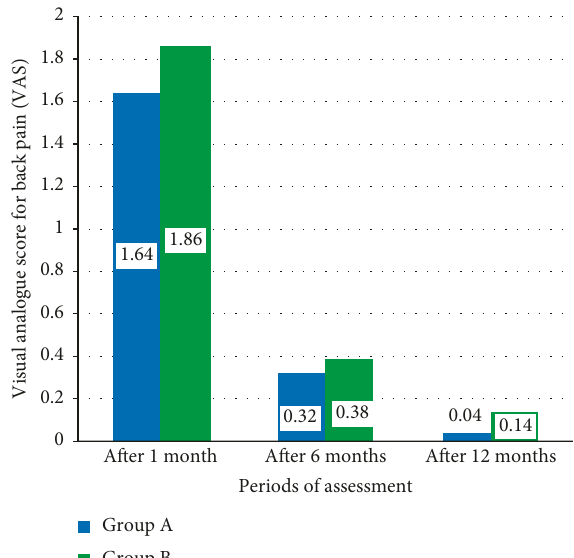
Figure 3: The mean differences of the postoperative visual analogue index (VAS) for leg pain between study